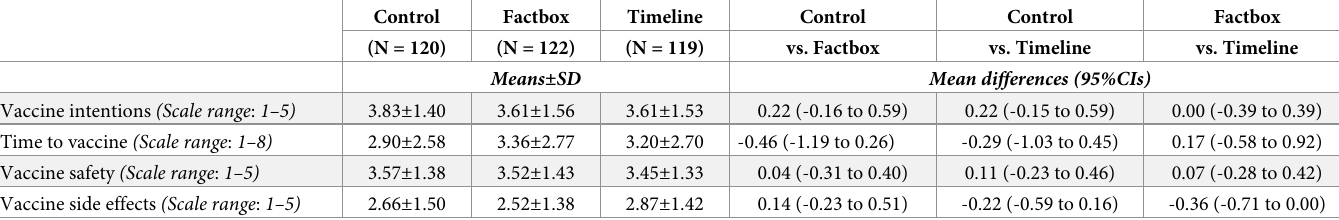
Table 2. Outcome measures according to group